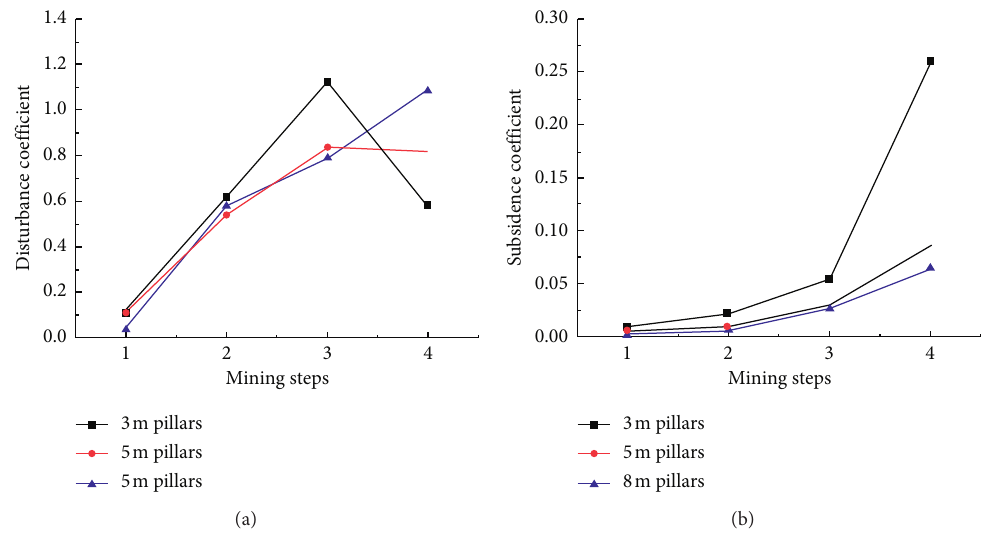
Figure 13: (a) Mining disturbance coefficient and (b) overlying rock subsidence coefficient for the three stope structures. Table 3: Law of deformation and failure for stopes in various mine types.